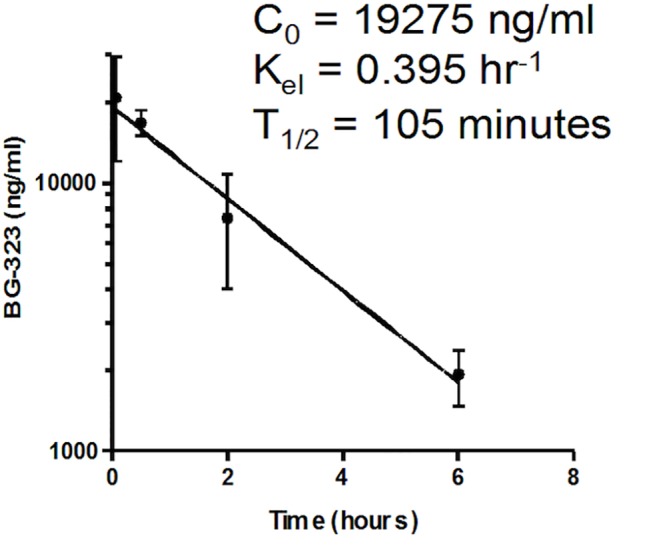
Half-life of BG-323 in mice.BG-323 was administered to mice in a 0.38 mL bolus of 5 mg/mL BG-323. Mice were bled at the indicated times and LC-MS/MS was performed on resulting sera to quantify the concentration of BG-323 present in each sample. Initial concentration (C0) was 19275 ng/mL, elimination rate constant (Kel) was 0.395 hr-1, and T1/2 was found to be 105 minutes.